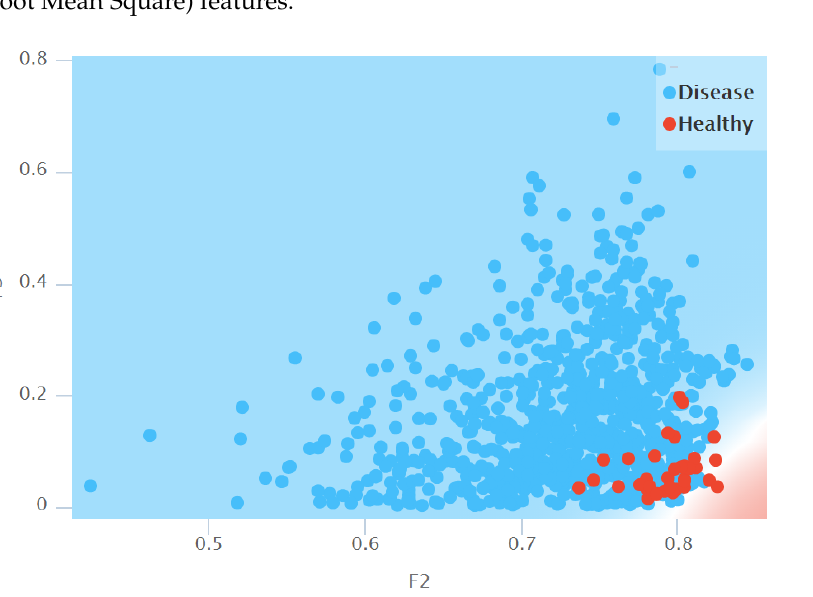
Figure 2. Scatterplot for the F 3 (i.e., Spectral Centroid) and F 2 (i.e., Root Mean Square) features.